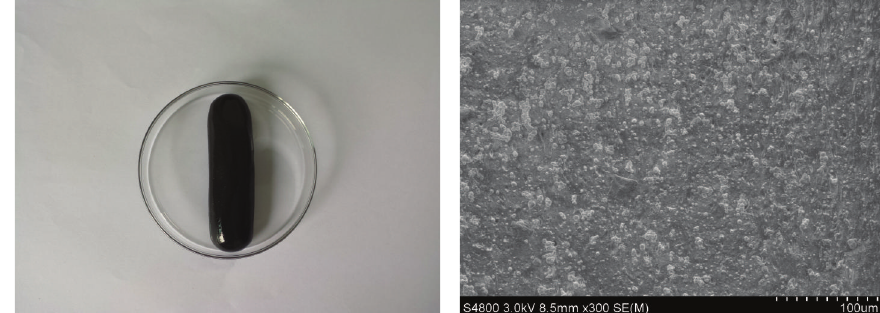
Figure 1: Prepared MRSP sample and SEM image of internal microstructure.